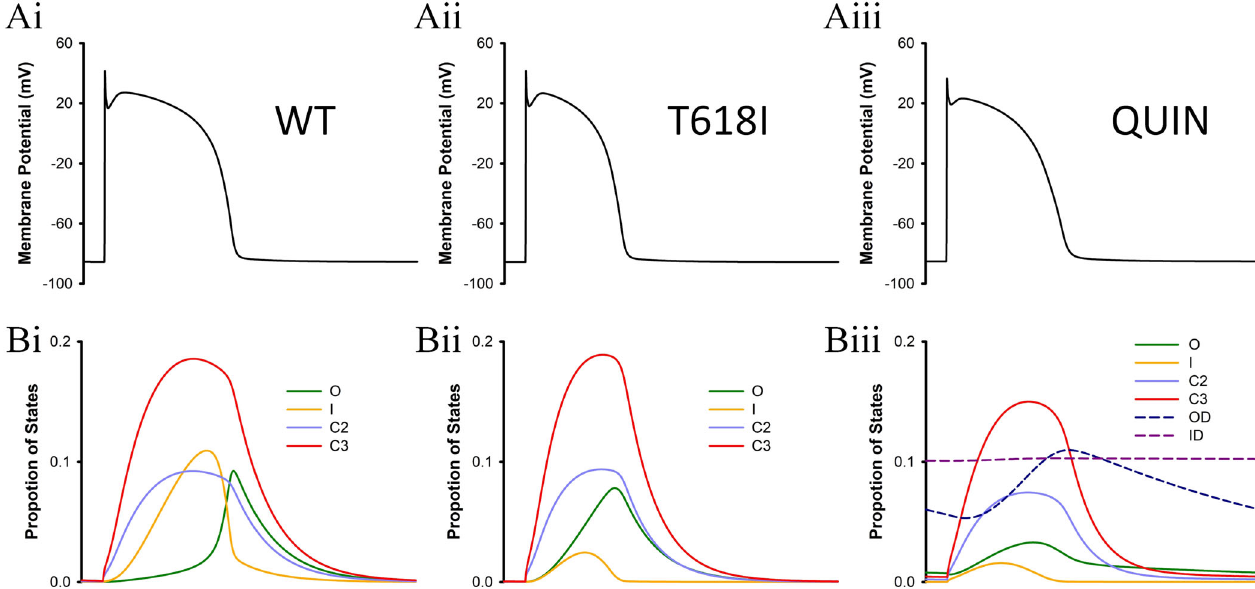
Fig. 8 Proportion of states under WT, T618I, and QUIN conditions. A Action potential traces. B The corresponding state proportions under different conditions. The Markov model demonstrated that the enhanced I Kr in T618I was due to the loss of inactivation, as evidenced by the signi fi cantly dropped proportion of the Inactivation ( “ I ” ) state in panels Bi and Bii . Simulation also showed that quinidine exerted its effects by directly deprecating the Open ( “ O ” ) state rather than restoring the “ I ” state (see panels Bii and Biii